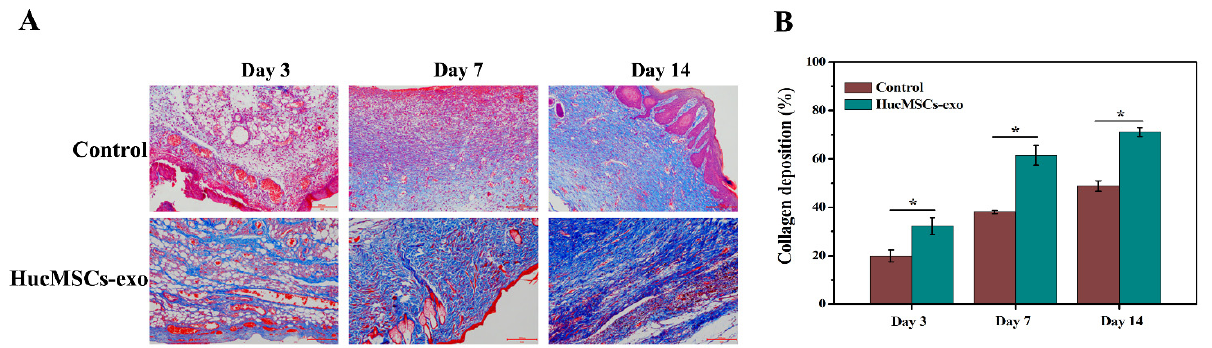
Figure 7. Masson’s trichrome staining in diabetic wound tissues on days 3, 7, and 14. ( A ) Representative images of Masson’s trichrome staining of wound sections. The scale bar is 200 µ m. ( B ) Quantitative analysis of pigmentation areas (n = 3). * p < 0.05 compared with the control group.